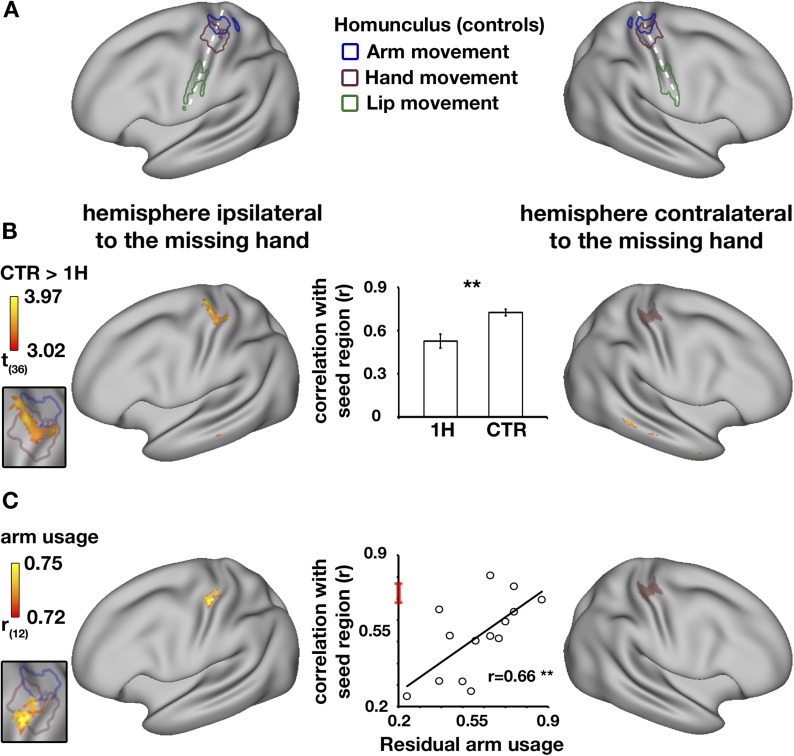
Decreased functional asymmetry in hand region functional connectivity during rest is associated with increased residual arm usage in daily tasks.(A) An illustration of the human sensorimotor homunculus, projected on a cortical surface map. Coloured lines show brain areas activated during execution of movements of the arms (blue), hands (purple), and lips (green) in the control group, using task-evoked fMRI scans. (B) Whole-brain group comparison (controls > one-handers) of resting-state functional connectivity using the missing hand's cortical territory as the seed-region. The seed-region (the mirror projection of intact/dominant hand activity, averaged across groups) is shown in purple shading. The orange-yellow clusters show areas with lower levels of connectivity to the missing hand territory in one-handers (corrected, p < 0.05). The insert on the left shows that the main resulting cluster overlaps with the task-evoked hand region, as measured in controls in (A), suggesting lower levels of inter-hemispheric connectivity between the cortical hand regions in one-handers. The bar plot in the middle reflects group-wise mean (±s.e.m.) connectivity levels between the seed-region and the intact hand ROI (defined based on intact/dominant hand activity, averaged across groups). (C) Whole-brain correlations between connectivity levels with the missing hand's seed-region (purple shading) and level of one-handers residual arm usage in daily tasks (level of bimanual usage). Significant correlations were restricted to the anterior aspect of the intact hand knob of the central sulcus, as can be seen in the insert to the left. Scatter plot in the middle reflects connectivity levels between the seed-region and the intact hand region (y axis) versus residual arm use (x axis). The red line on the y axis shows the mean ± confidence interval of controls' hand region inter-hemispheric connectivity. The significant positive correlation (p < 0.005) reflects that one-handers using their residual arm more frequently to support bimanual tasks showed higher levels of hand region functional connectivity, similar to those of control participants. This suggests that increased residual arm usage to support bimanual tasks normalises the aberrantly reduced levels of inter-hemispheric connectivity in one-handers, shown in (B). 1H = one-handers; CTR = controls; Asterisks denote significance at the level of **p < 0.005.